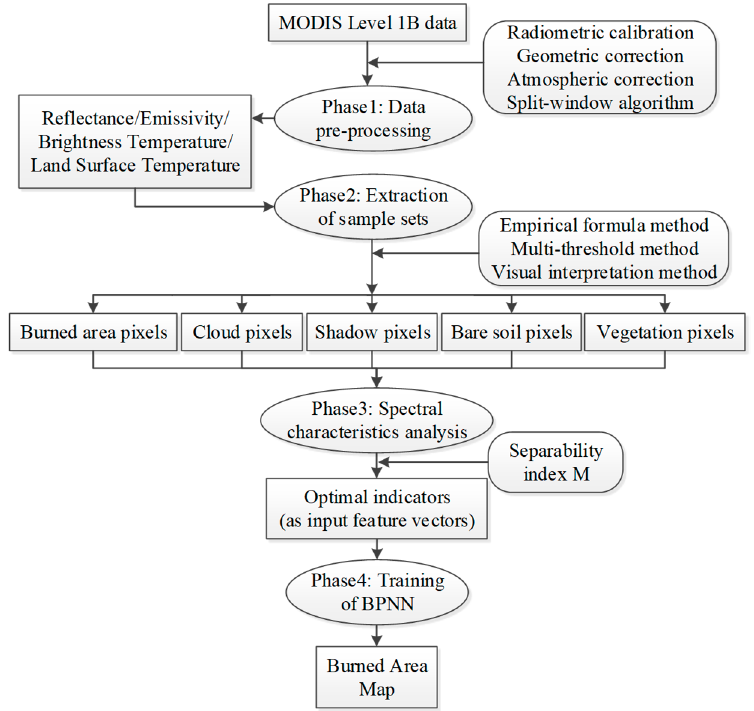
Figure 2. The flowchart of the new burned area mapping method.